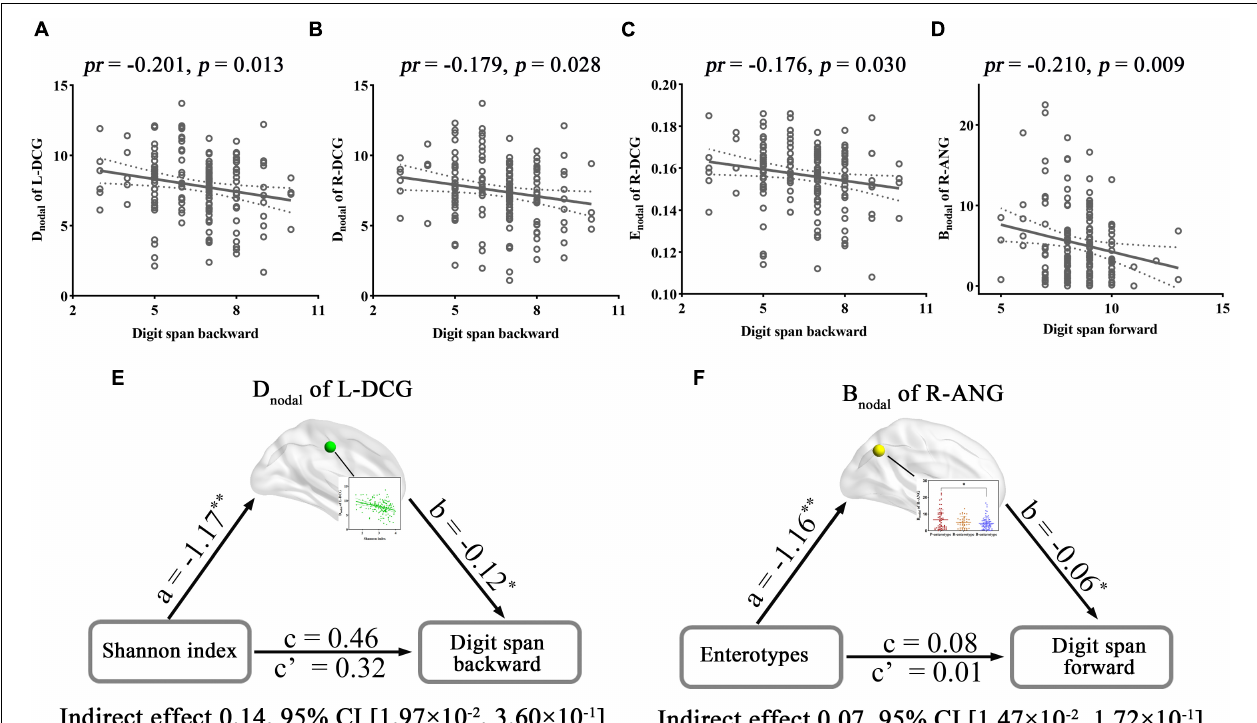
FIGURE 7 | Correlations and mediations between regional topological properties of FC, gut microbiota, and cognition. (A–D) Scatter plots of the correlations between topological metrics of FC and cognition. (E,F) The mediation analyses between gut microbiota (X) and digit span forward and backward (Y), with nodal parameters of FC as the mediator (M). Path coefficients with p- values ( ∗ p < 0.05 and ∗∗ p < 0.01, respectively). ANG, angular gyrus; B nodal , nodal betweenness; CI, confidence interval; D nodal , nodal degree centrality; DCG, median cingulate and paracingulate gyri; E nodal , nodal efficiency; FC, functional connectivity; L, left; pr , partial correlation coefficient; R,